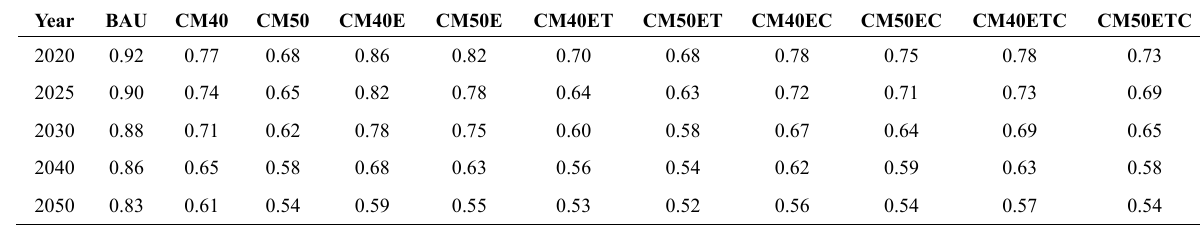
Table A8. CO 2 emission intensity from 2020 to